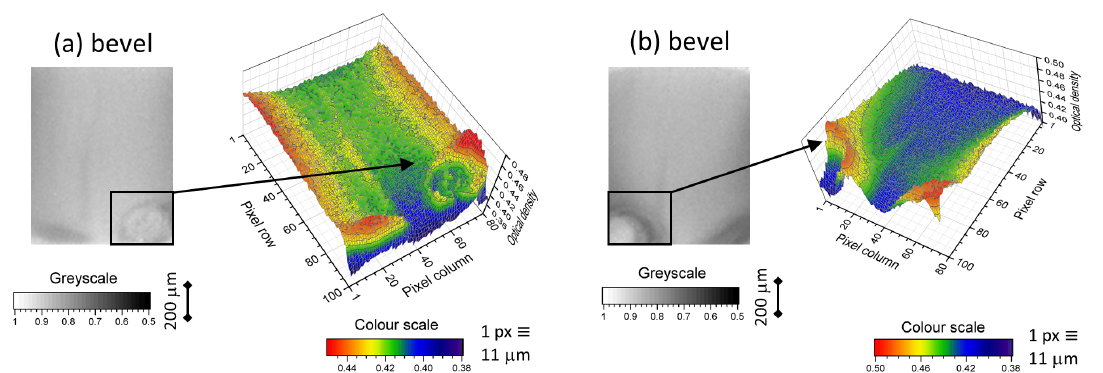
Figure 9. Two examples, ( a , b ), of bubbles of air forming, between coating and bulk, on bevels. The bubble artefacts can be observed in 2D greyscale images by ring structures or as hollowed-out circular swells in OD in 3D